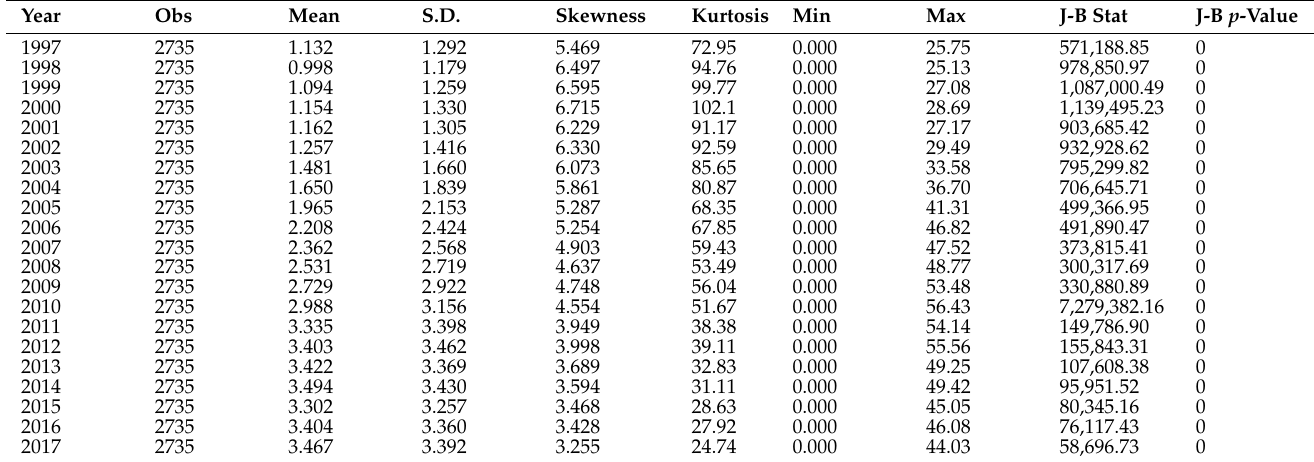
Table 1. The descriptive statistics of the county-level annual carbon emission data.